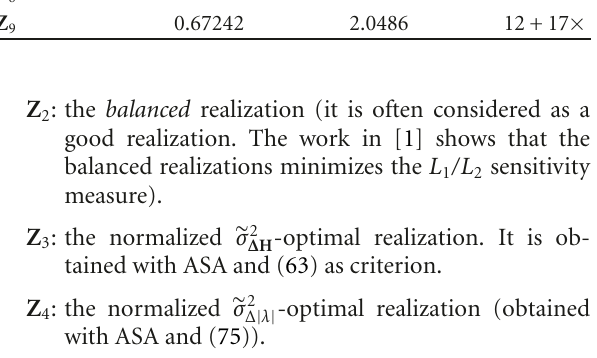
Table 2: (cid:11) σ 2 Δ